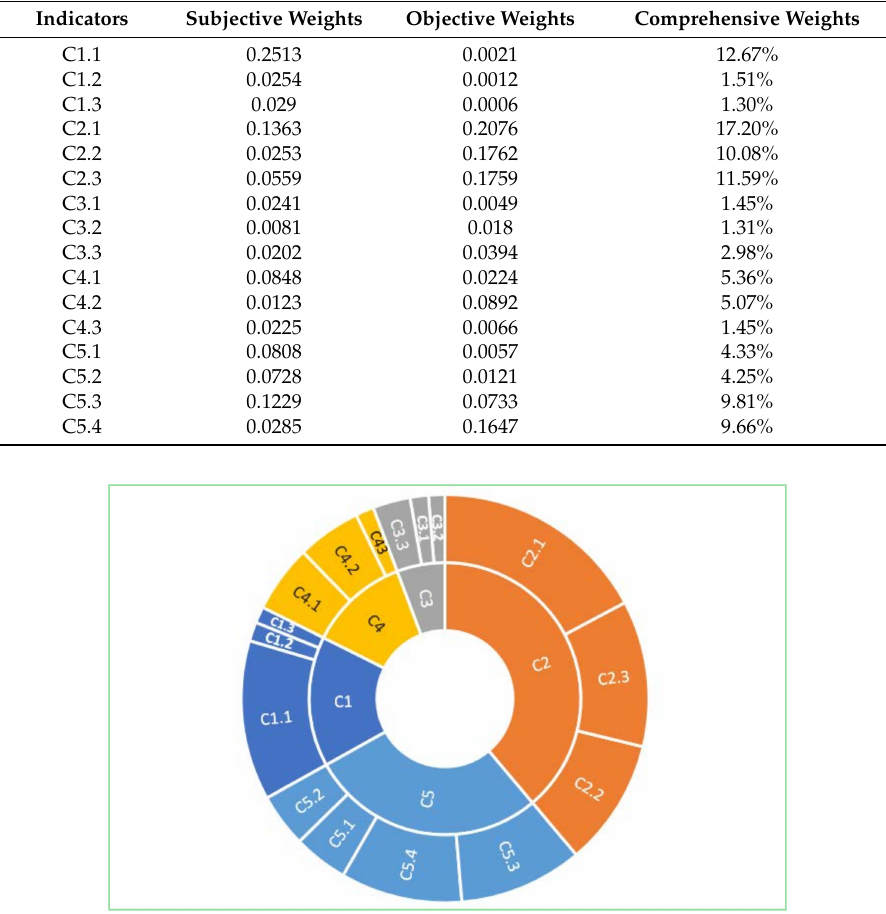
Figure 7. Criteria and sub-criteria weights.